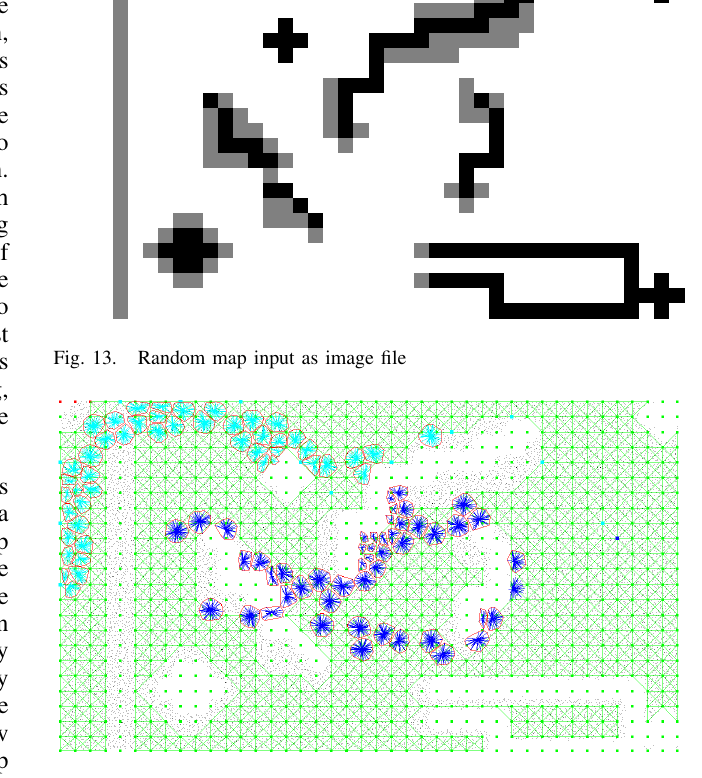
Fig. 14. Random scenario